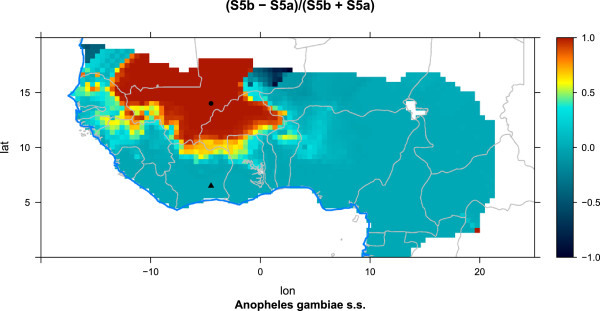
Relative change in dispersal (mean over 5 years) for An. gambiae s.s. with (mosqTran(a)) and without (mosqTran(b)) An. arabiensis. The black solid circle and triangle indicate the initial position of An. arabiensis and An. gambiae s.s., respectively.